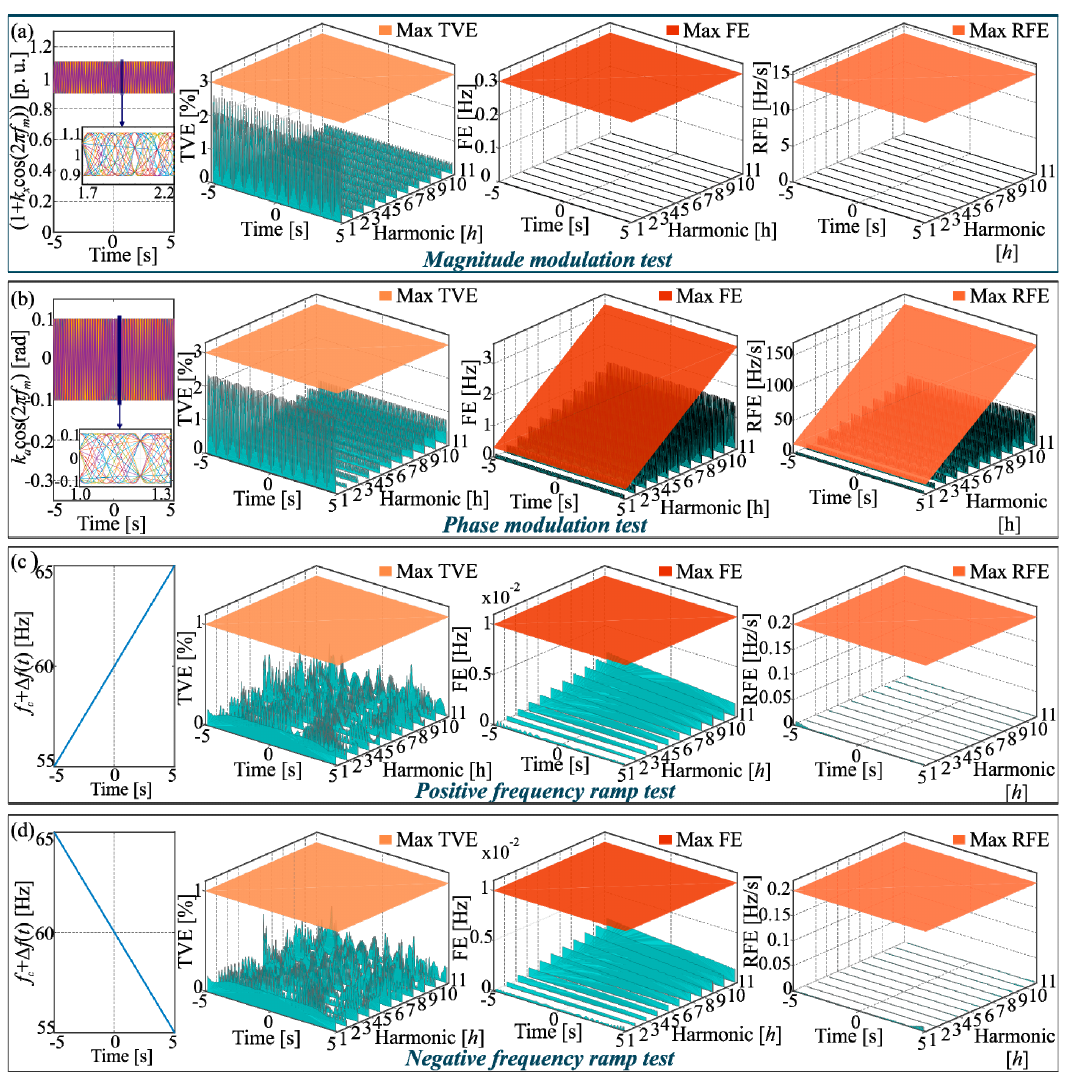
Figure 5. Dynamic tests: ( a ) magnitude modulation test, ( b ) phase modulation test, ( c ) positive ramp test, and ( d ) negative ramp test.